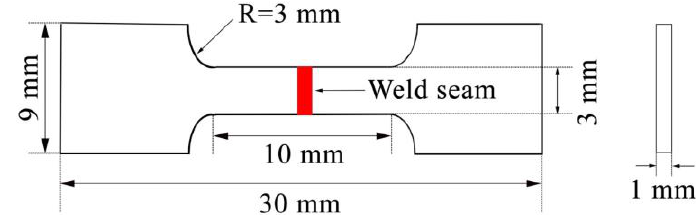
Figure 3. Sketch showing the shape and dimensions of the tensile samples.